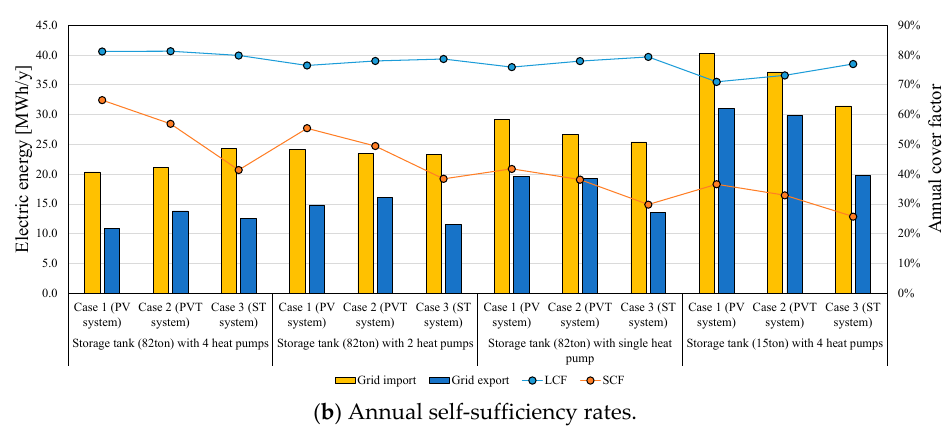
Figure 6. Annual self-sufficiency of the proposed systems to serve the DHW load.